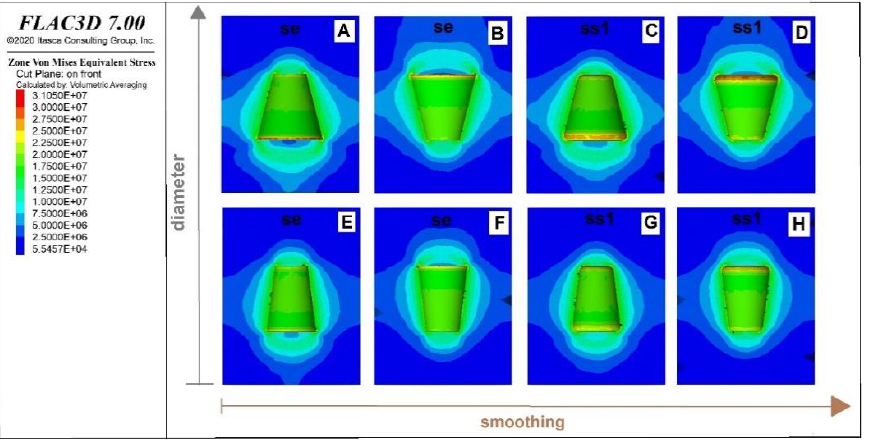
Figure 12. The vMS in the simulated caverns; initial period: ( A – D ) diameter of 120 m, ( E – H ) diameter of 90 m.